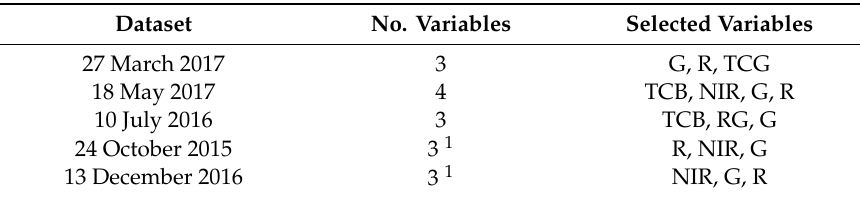
Table 3. Variable selection results for the final RF classification model for the five single season datasets.